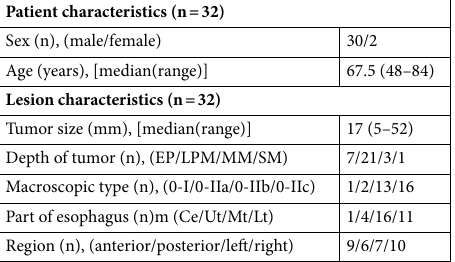
Table 1. Characteristics of the validation video sets (the slow-speed validation video sets).